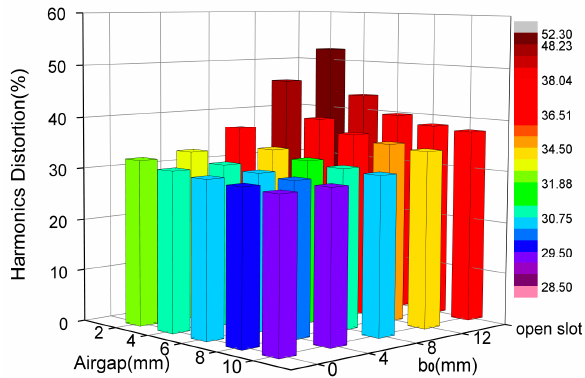
Figure 7. Airgap harmonic distortion rate.